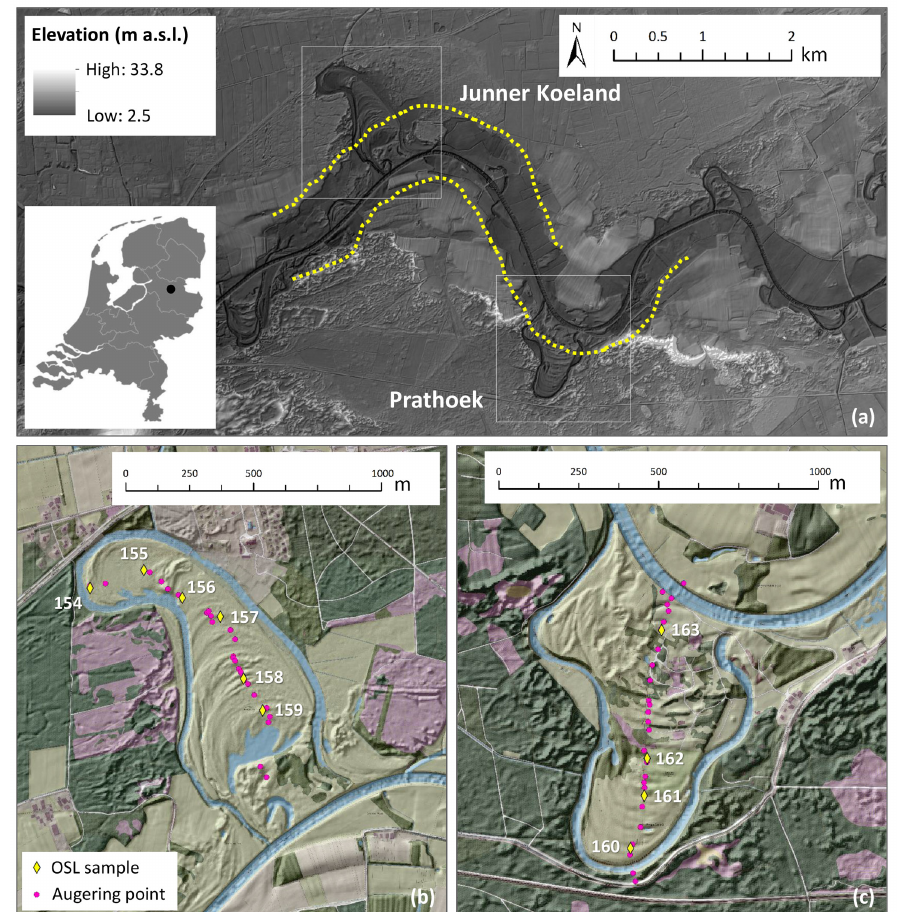
Figure 1. Location of the study area (a) , showing the two meander bends Junner Koeland (b) and Prathoek (c) . Dotted line in panel (a) indicates the valley side; ma.s.l.: metres above sea level. White numbers along the coring transects in panels (b) and (c) indicate OSL sample locations by abbreviated sample code (all should be preceded by NCL-2415). Samples NCL-2415154–162 were collected in scroll bar deposits; sample NCL-2415163 was collected in a terrace remnant. Lithological cross sections and lithogenetic interpretation are provided in Candel et al. (2018). Digital elevation model (AHN2; horizontal resolution 5m, vertical resolution 0.2m): AHN (2018), Van Heerd et al. (2000). Topography (3200pixelskm − 1 ): OpenTopo, Van Aalst